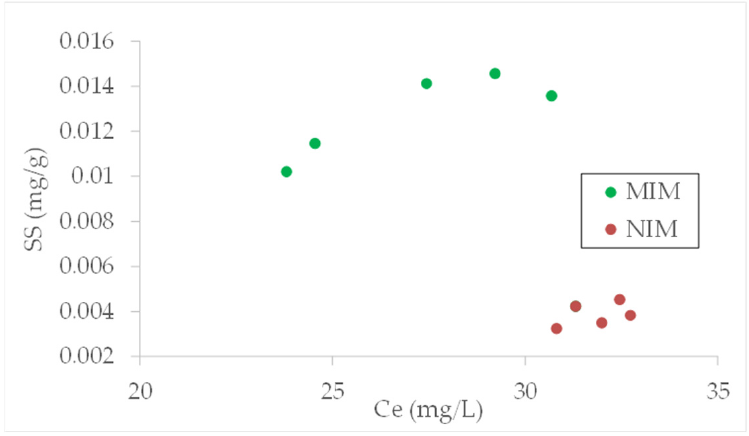
Figure 2. The relationship between dynamic sorption (DS) and contact